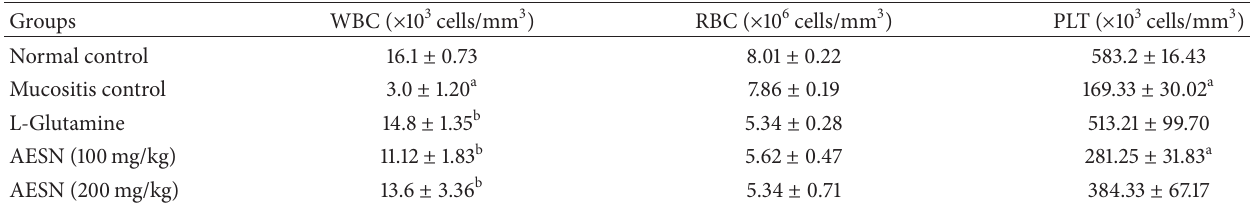
Table 5: Change in hematological parameter on 12th day of study period in methotrexate induced oral mucositis. Groups